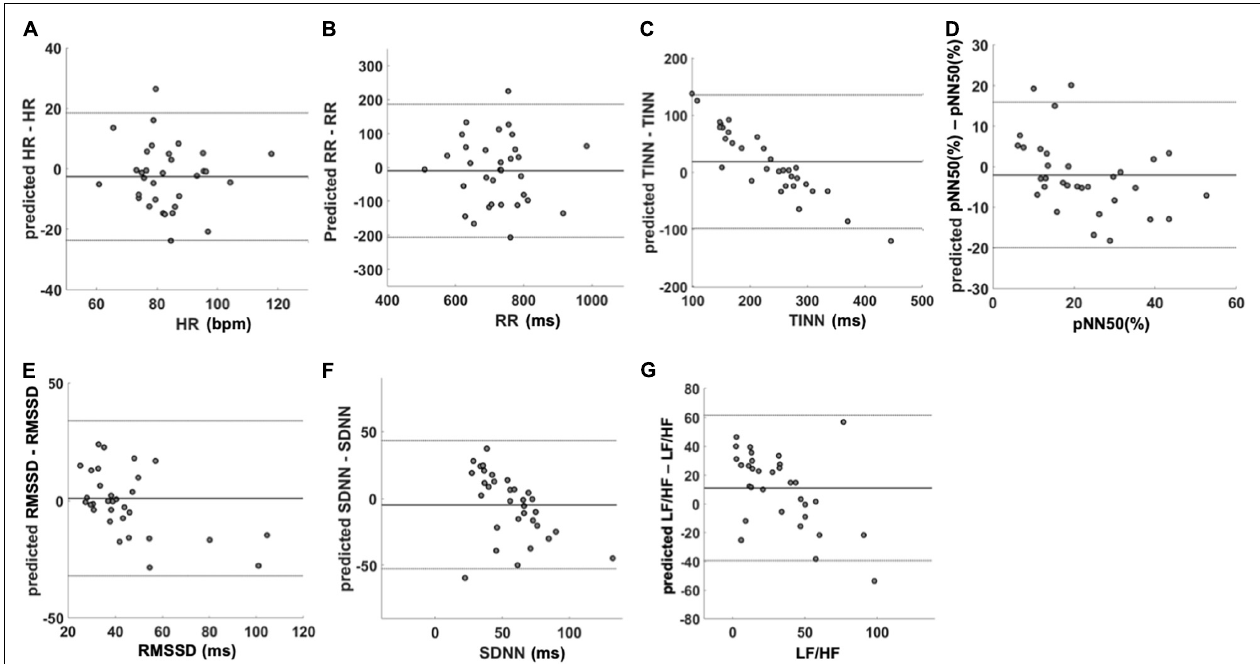
FIGURE 5 | Bland–Altman plots of the predicted HRV variables. The figure shows the agreement between the variables measured with PPG and the predicted ones using IRT data. In each figure, mean difference and limit of agreement are reported. (A) HR, (B) RR, (C) TINN, (D) pNN50 (%), (E) RMSSD, (F) SDNN, and (G) LF/HF. HR, heart rate; RR, interval between consecutive R peaks; pNN50 (%), percentage of successive RR intervals that differ by more than 50 ms; RMSSD, root mean square of successive RR interval differences; SDNN, standard deviation of NN intervals; LF/HF, ratio of LF-to-HF